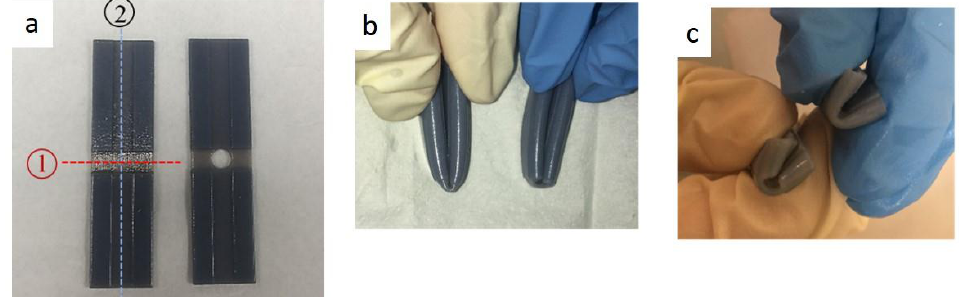
Figure 17. Crossfolding for the 0.5 mm sample. ( a ) Printed specimens with and without a hole; ( b ) Method 1—Folding line 2, followed by folding line 1; ( c ) Method 2—Folding line 1, followed by folding line 2.